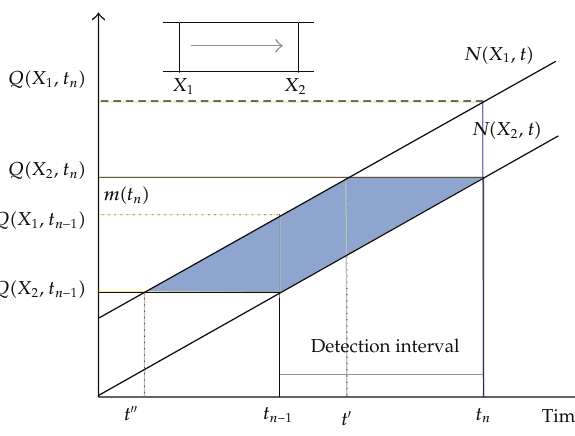
Figure 2: Illustration of input output